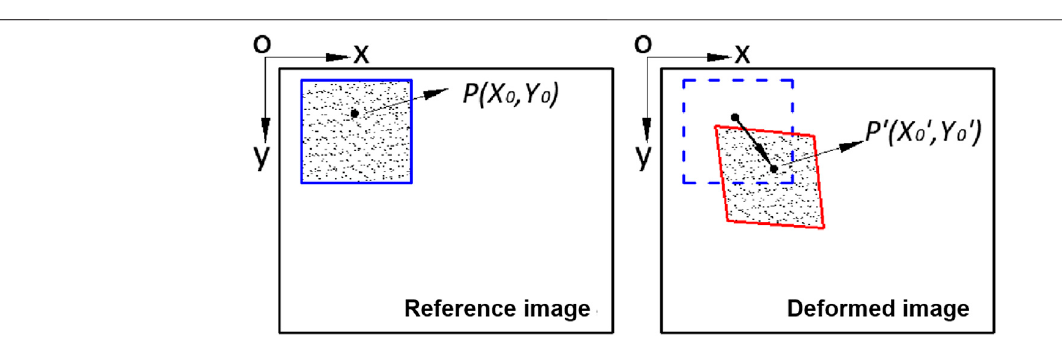
FIGURE 2 | Basic principle of